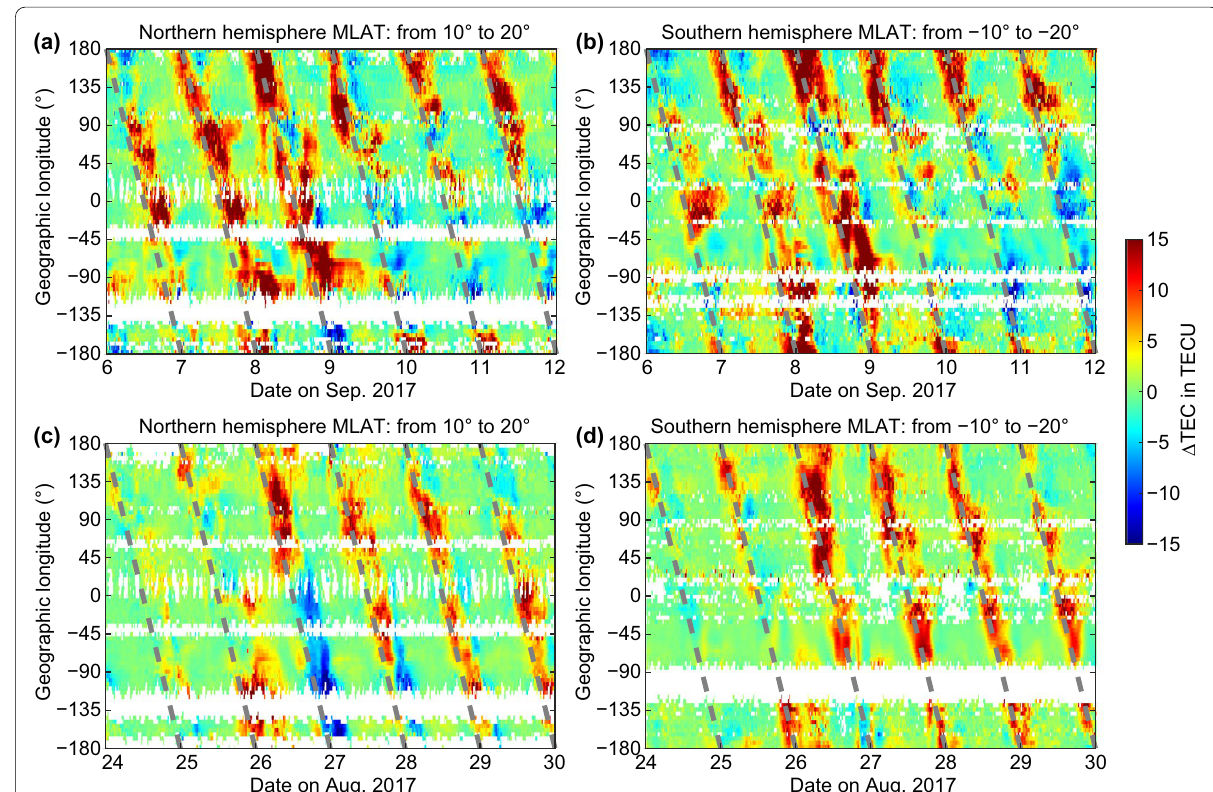
Fig. 2 The longitude versus UTC (in a time cadence of 15 min) variations of ionospheric perturbation (∆TEC) for the ( a and c ) northern (10° to 20° MLAT) and ( b and d ) southern ( 10° to 20° MLAT) EIA crest regions during geomagnetic storms on ( a and b ) 6–11 September 2017 and ( c and − − d ) 24–29 August 2018. The gray dashed lines represent the local noon at different